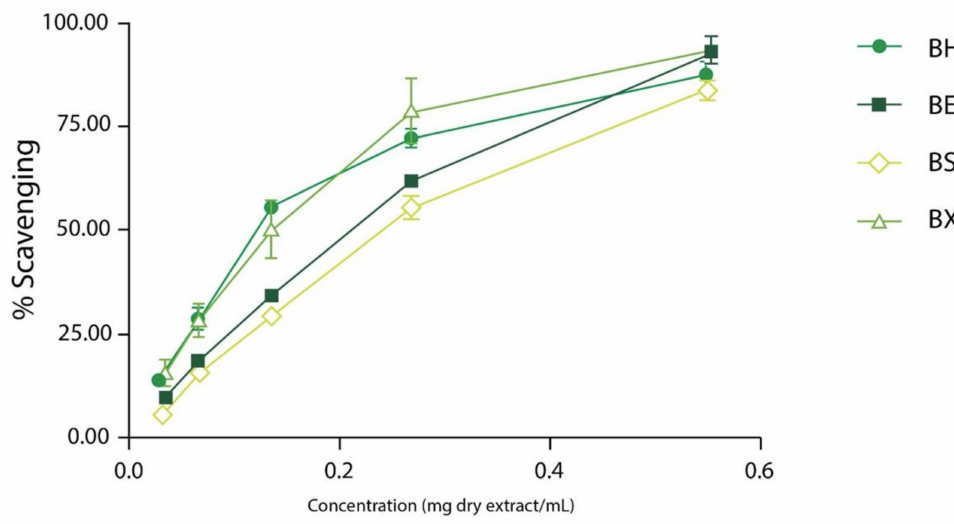
Figure 3. DPPH radical scavenging activity. Results are expressed as the mean ± SD of three independent experiments performed in duplicate, face to untreated control.